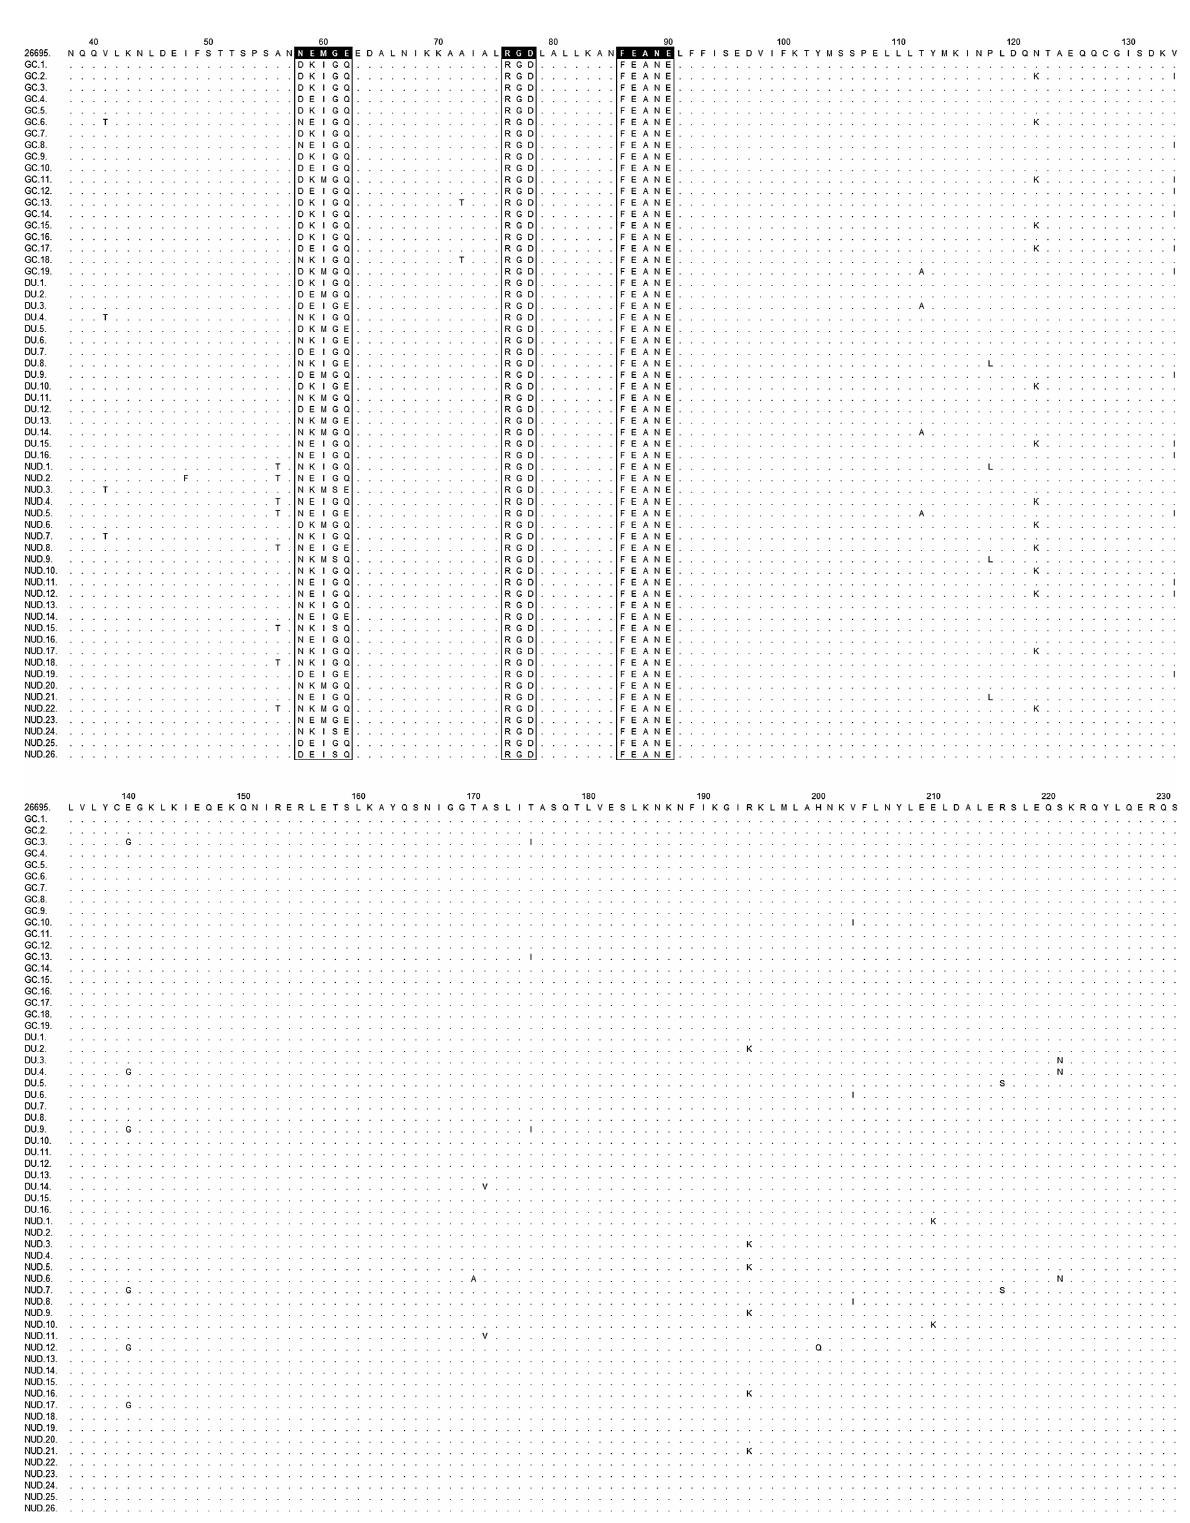
Figure 1. The sequences of 61 CagL (+) H. pylori DNA isolates that were aligned with the sequence of strain ATCC